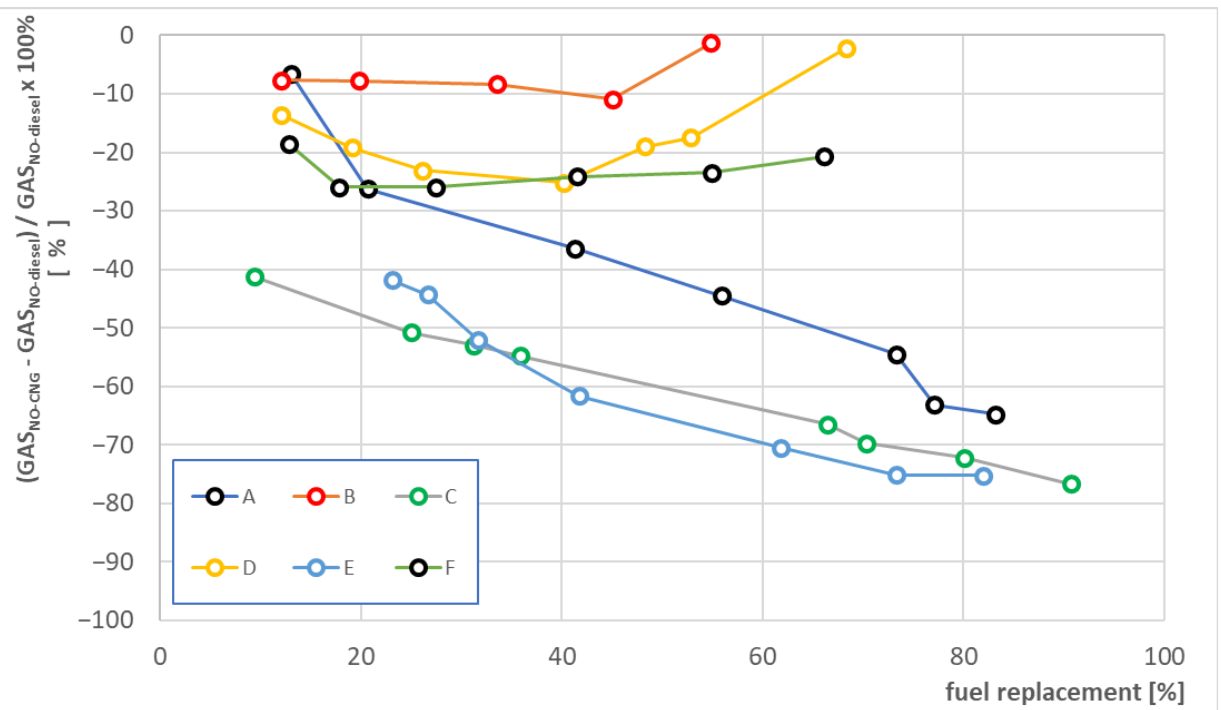
Figure 6. Curves from A to F showing the changes in the emission of nitric oxide as the comparison of exhaust gas temperature noted only in single fuel (diesel) working mode for individual engine operating points, where the rotation speed, power, and torque were constant, as a dual fuel mode (where engine uses CNG and diesel fuel) replacement function.